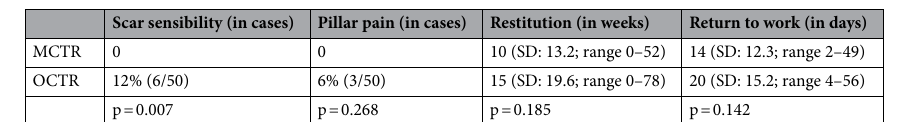
Table 2. Postoperative follow-up of MCTR versus OCTR. Specific follow-up comparisons show a statistically significant superiority of the MCTR group in terms of scar sensibility. Restitution and return to work are presented at mean. MCTR mini-open carpal tunnel release, OCTR Open carpal tunnel release.